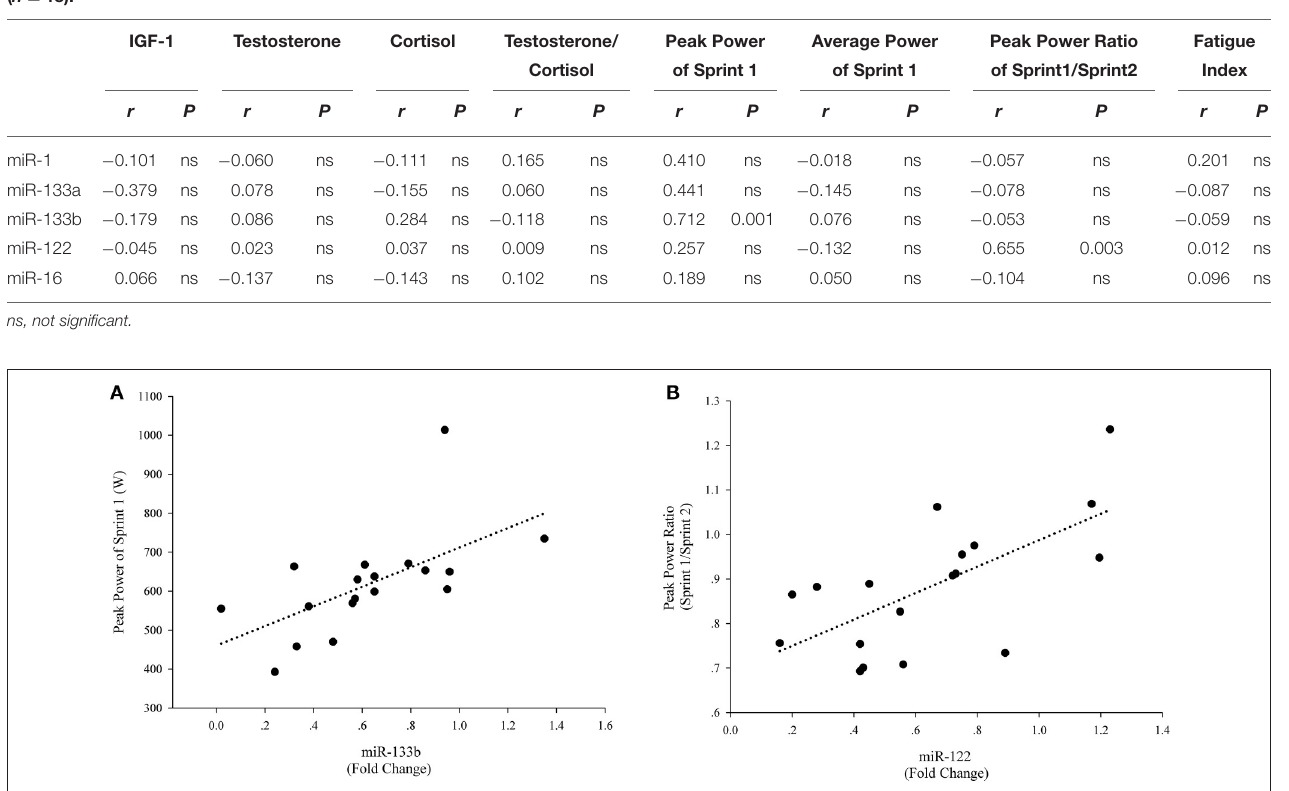
FIGURE 4 | Correlations of plasma miRNAs and exercise-related anaerobic parameters. For each participant, baseline c-miRNAs levels before the exercise were assigned a fold change of 1, to which measurements obtained after the exercise were compared. A direct correlation was observed between levels of peak power of Sprint 1 and levels of plasma miR-133b (Post exercise) (A) A direct correlation was also observed between the peak power ratio of Sprint 1/Sprint 2 and levels of miR-122 (Post exercise) (B)